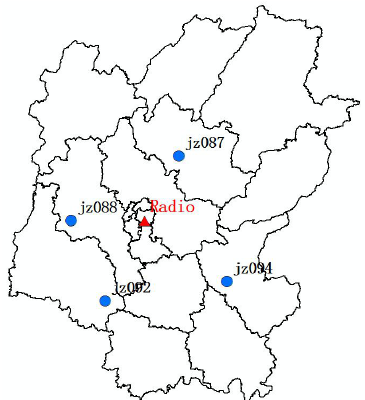
Figure 1. Distribution map of CORS stations and radiosonde stations used in the